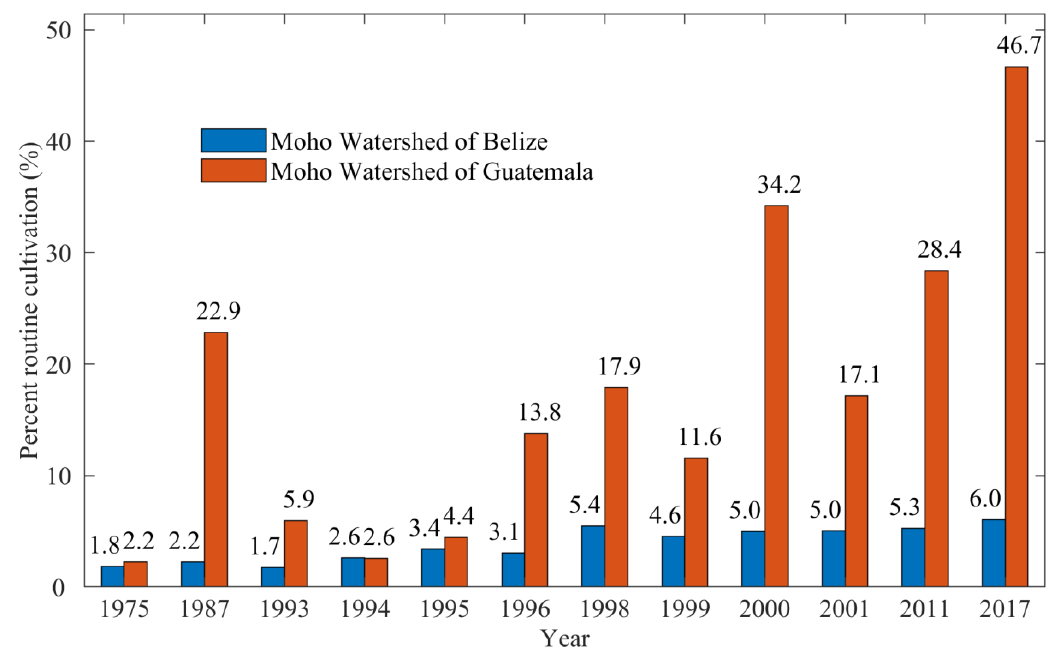
Figure 5. Percentage of area under routine cultivation in Moho River watershed separated by the Belize/Guatemala border.